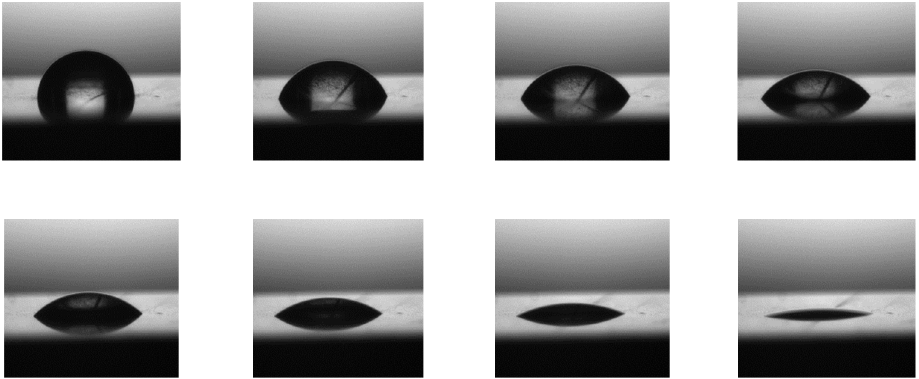
Figure 4. Evolution of an evaporating water droplet at a temperature of 21 °C (the initial droplet radius R d = 0.7mm, the initial contact angle θ 0 = 97°). Time step equals 300 s.